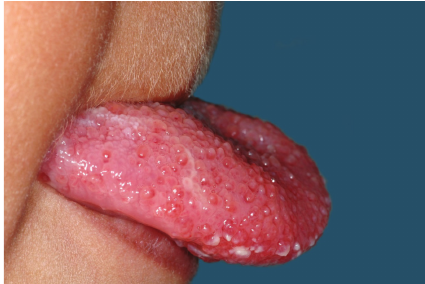
Figure 2: Clinical photograph of grossly enlarged papillae on the anterior one-third of the tongue.